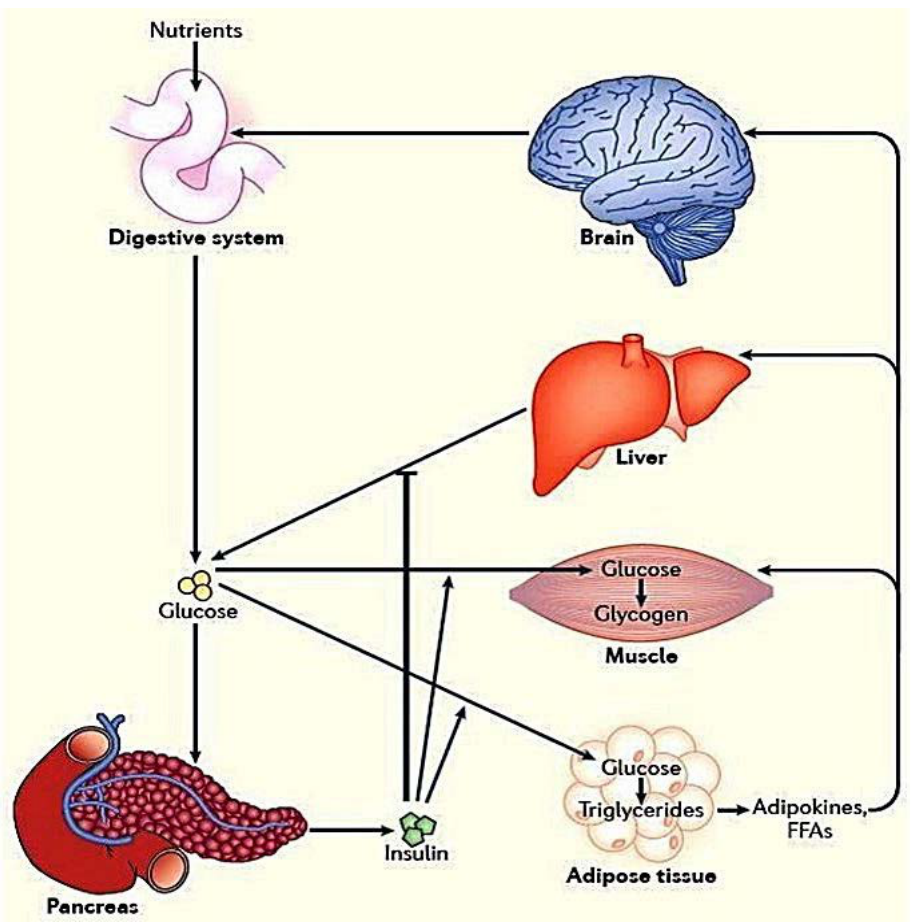
Figure 1. Visualization of the whole-body glucose homeostasis. Glucose homeostasis rely on the function of several organs as well as tissues, including the digestive system, pancreas, brain, liver, muscle and adipose tissue with the help of insulin stimulation, these tissues obtain energy and represent glucose to other parts via the available molecules such as insulin. Flaws in the detecting of the energy homeostasis, and the ability to respond appropriately, result in type 2 diabetes mellitus, major metabolic diseases. Abbreviation; FFAs: free fatty acids.